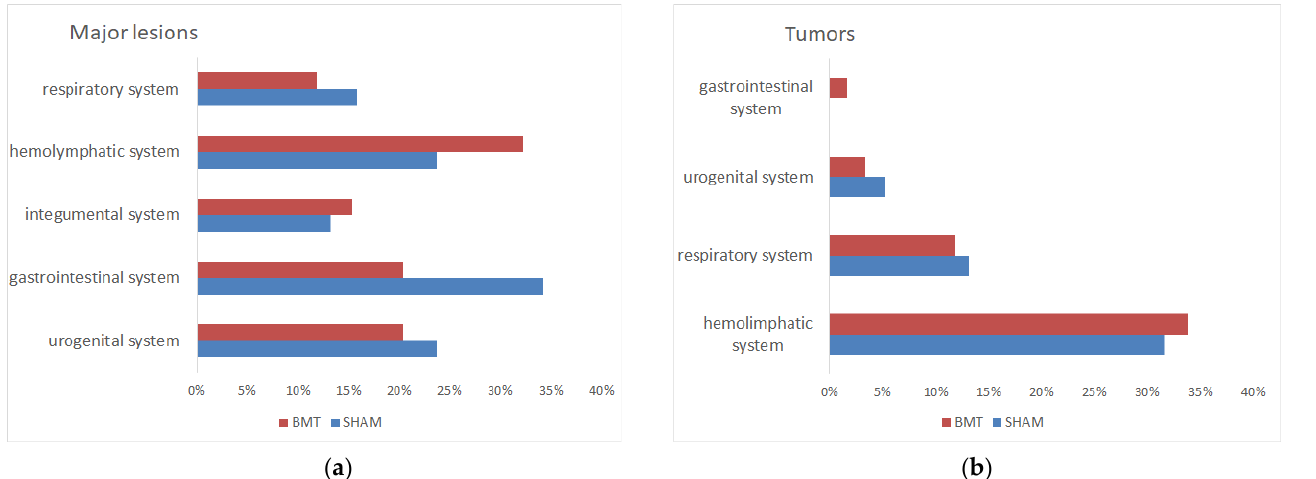
Figure 4. Results of pathomorphological analyses of the aged mice that received heterochronic BM transplantation (BMT, n = 59) and of the aged control mice (SHAM, n = 38); ( a ) the percentage of major lesions in different organ systems; ( b ) the percentage of tumors in different organ systems.